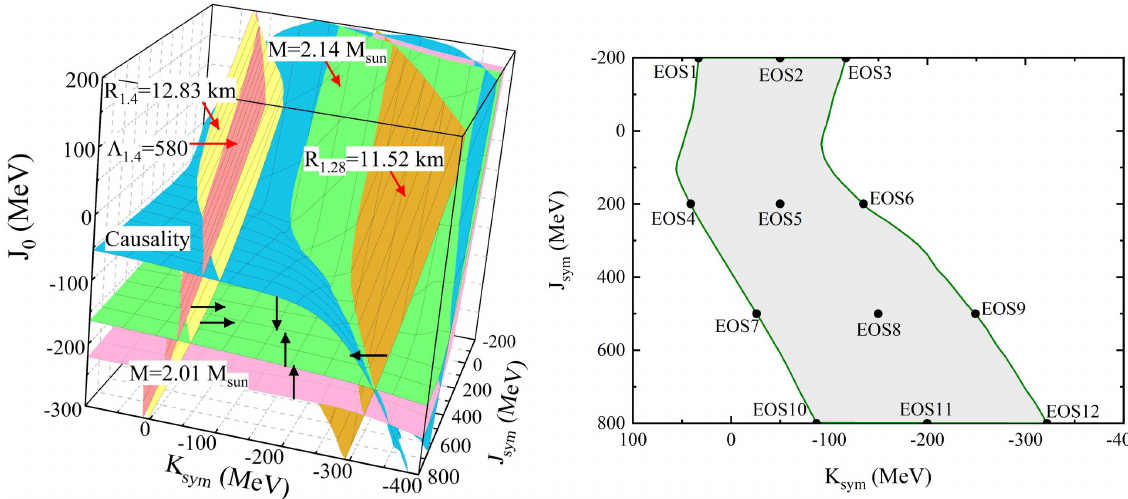
Figure 4. ( Left ) The constant surfaces of M = 2.01 M (cid:12) (pink surface), M = 2.14 M (cid:12) (green surface), R 1.4 = 12.83 km (yellow surface), Λ 1.4 = 580 (red surface), R 1.28 = 11.52 km (orange surface), and causality condition (blue surface) in the 3-dimensional parameter space of K sym − J sym − J 0 . The black arrows show the directions supporting the corresponding constraints, and the red arrows direct to the corresponding surfaces. ( Right ) Boundaries of the symmetry energy in the K sym − J sym plane. Modified from the figures originally published in